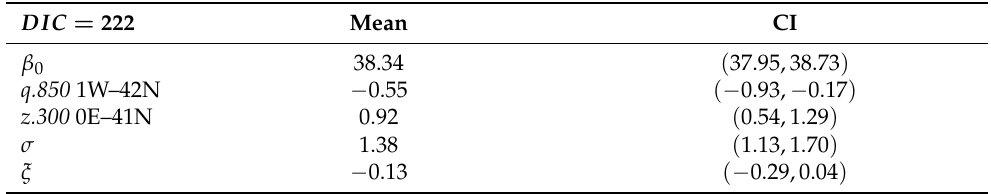
Table A4. Posterior mean and 95% CI of the final GEV model parameters according to the GEV-SSVS selection. Zaragoza